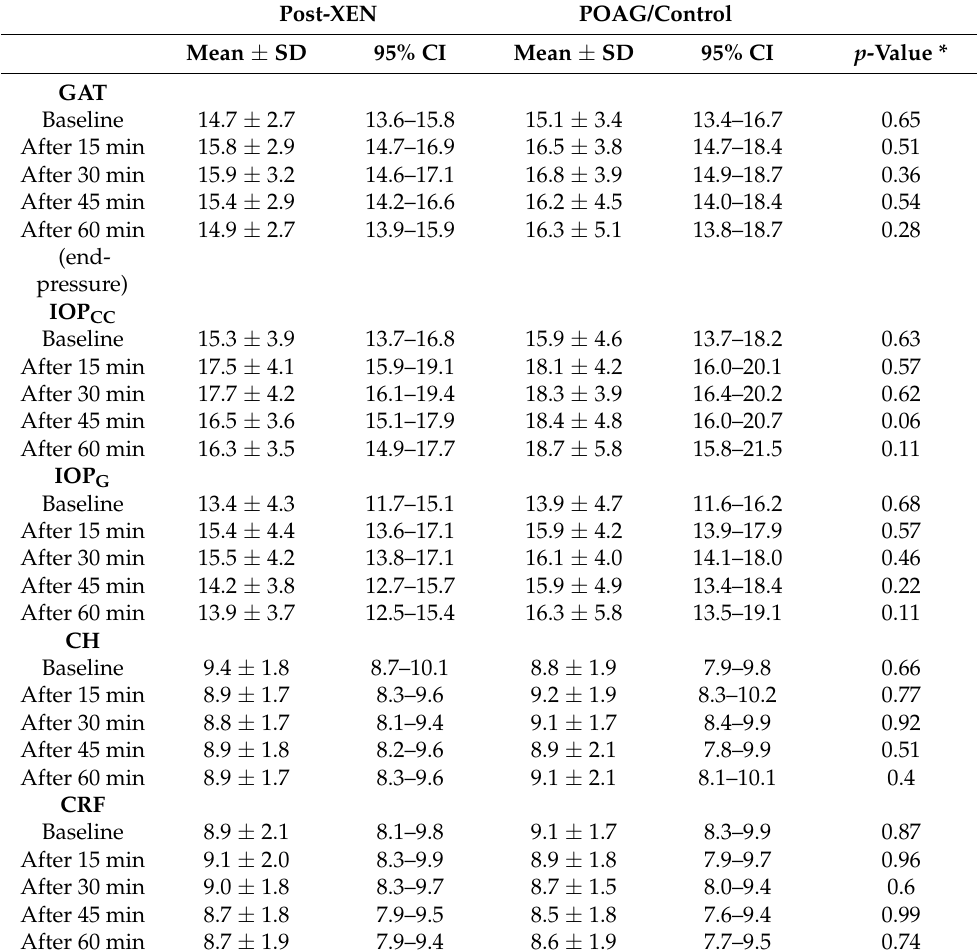
Table 3. Summary of WDT results in the post-XEN and control